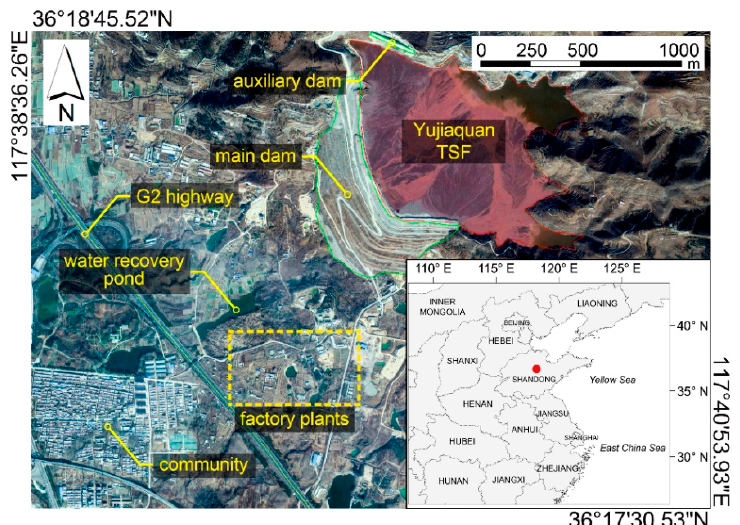
Figure 2. Aerial image of the research area, its location in China (insert), Yujiaquan tailings storage facility (TSF), and the downstream important facilities.